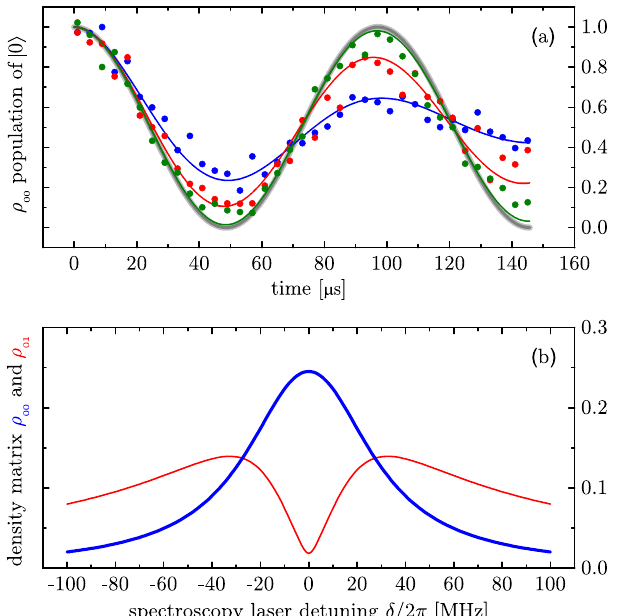
Figure 3. ( a ) Rabi flopping with Ω RF = 2 π × 10.3 kHz in the unobserved case as in Fig. 2 without the spectroscopy laser on Ω opt = 0 (grey, thick). With a relatively weak spectroscopy laser Ω opt = 2 π × 0.6 MHz on, the Rabi flopping is not stopped instantaneously as in Fig. 2 but damped out with a time constant that depends on the spectroscopy laser detuning δ . Examples are for δ = 2 π × 6.6 MHz, 2 π × 35 MHz and 2 π × 122 MHz (blue, red and green respectively). The closer the spectroscopy laser is tuned to resonance, the larger the rate of spontaneous photons that destroy the coherence ρ 01 . Parameters, including γ = 2 π × 41.8 MHz, are adapted to be compared with our experimental data (solid circles). ( b ) A Lorentzian line shape is obtained by measuring the occupation ρ 00 of the |0 〉 state (blue, thick) after the Rabi flopping between |0 〉 and |1 〉 has been evolved for a fixed time. In this example this time interval was chosen to correspond to a π -pulse. Other choices are possible and may lead to a signal inversion (dip rather than a peak). The magnitude of the detuning dependent coherence ρ 01 is shown in the red (thin)